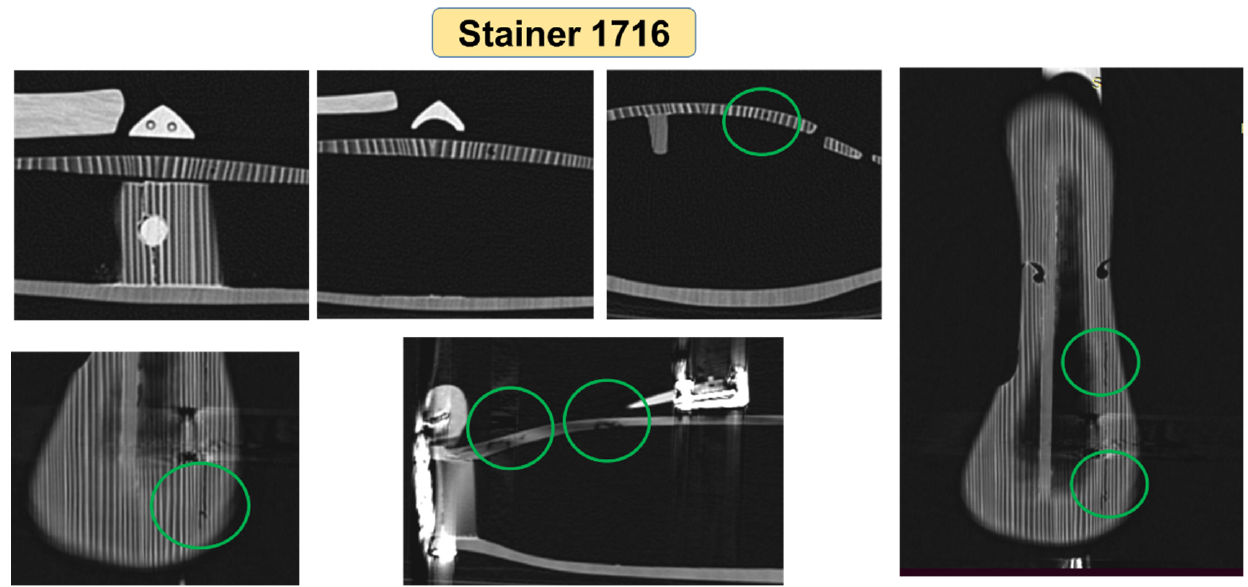
Figure 13. The trajectory of voids produced by coleoptera in case of the violin “Stainer, 1716”.